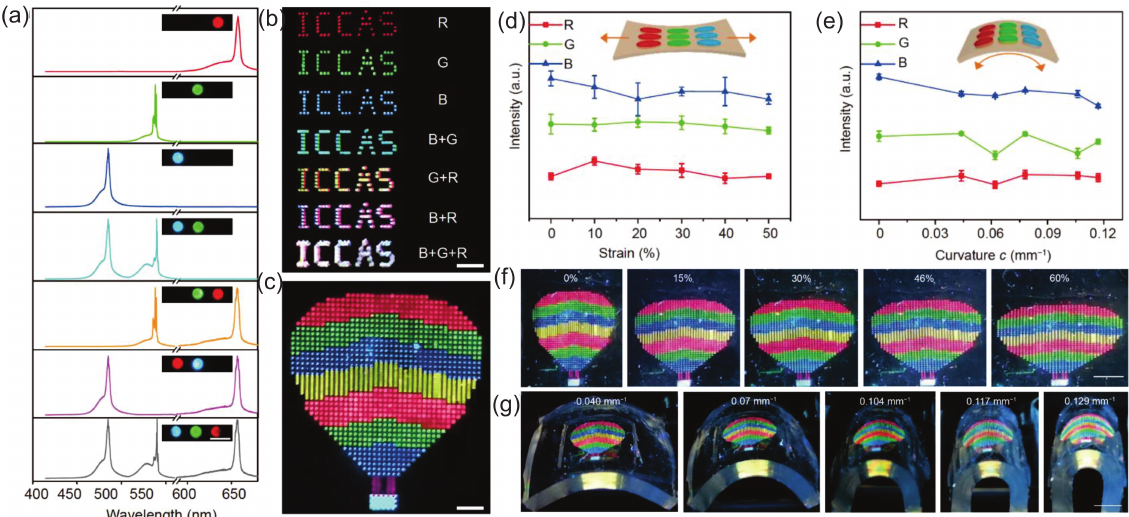
Figure 6. Full-color and pixelated flexible laser display. ( a ) Lasing spectra of different combinations of pixelated micro RLs. Three different Pe-NCs were used to provide RGB colors. ( b ) “ICCAS” patterns of different combinations of pixelated micro RLs. ( c ) A hot air balloon pattern from a multipixels array on a PDMS substrate. ( d ) Lasing intensities of the identical pixel at 658, 536 and 483 nm in terms of stretching strain values. ( e ) Lasing intensities of the identical pixel at 658, 536 and 483 nm in terms of bending curvature values. ( f ) Photographs of stretching multipixel display under different strains. ( g ) Photographs of bending multipixel display under different curvatures. Adapted from Ref. [43] with permission from Science China Press and Springer-Verlag GmbH Germany, part of Springer